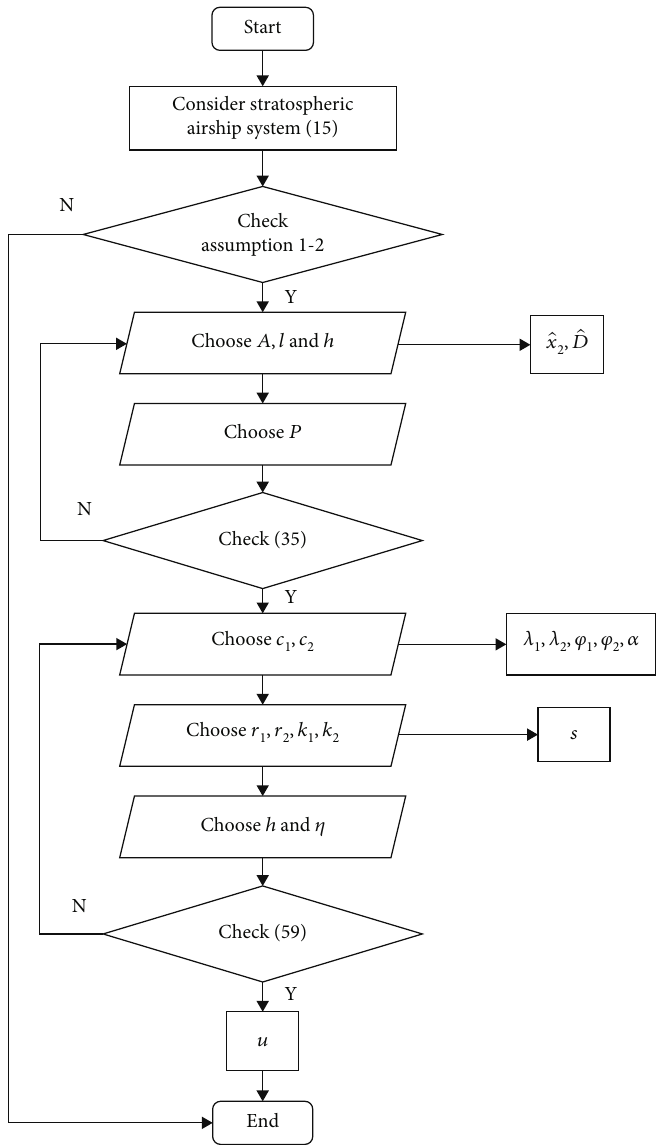
Figure 3: The fl ow chart of the robust fi nite-time controller design